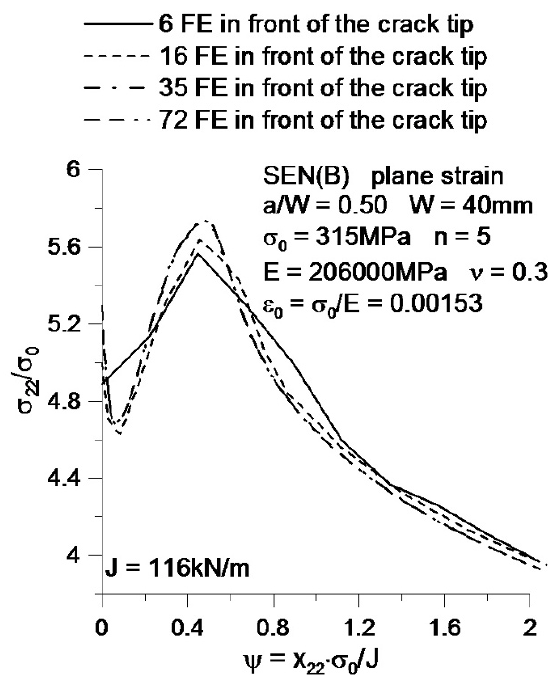
Figure 2. The influence of the number of the FE between the crack tipandtheopeningstressmaximumlocation σ along θ = 22 0 ◦ directiononthestressdistributionforSEN(B)specimen for r ≤ 2 J/σ (based on [11, 14, 0